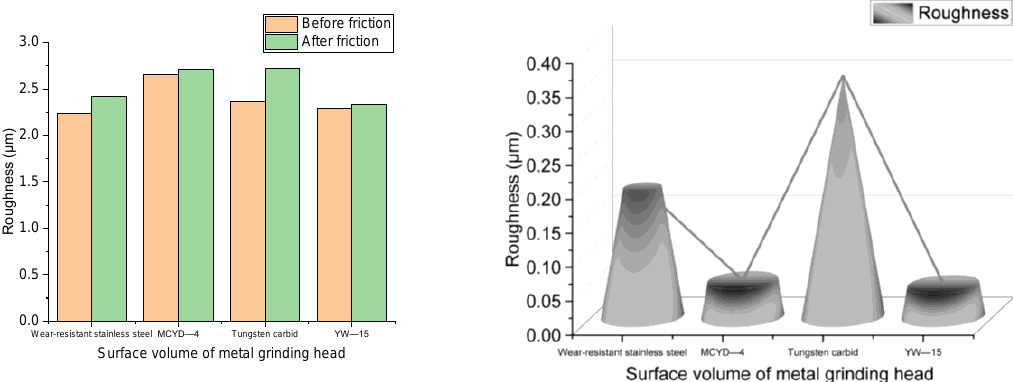
Figure 16. Roughness of metal surface before and after friction between different metals and NR/BR composites.